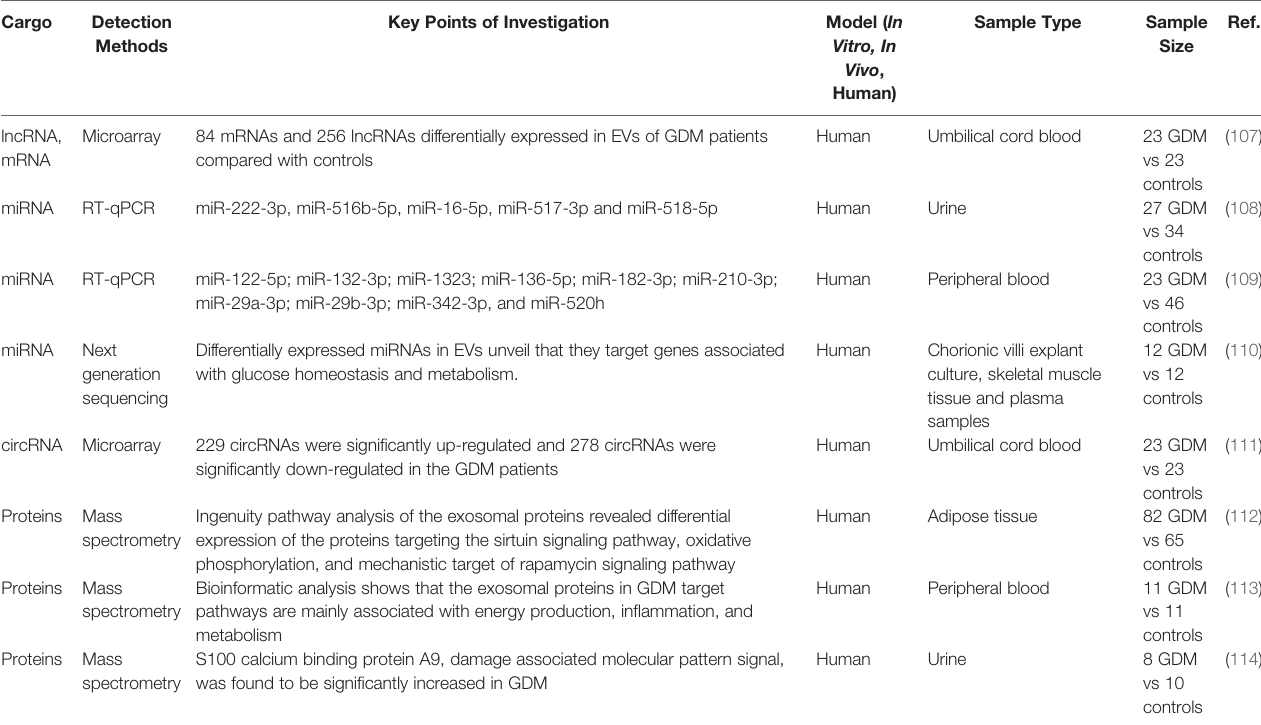
TABLE 3 | Extracellular vehicles and their cargos in